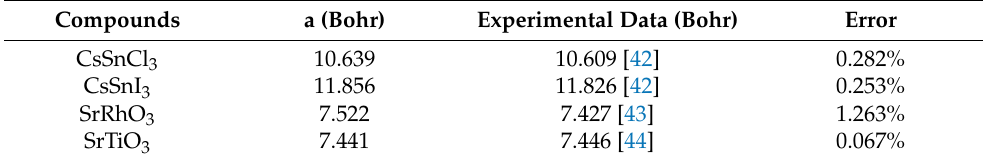
Table 1. Calculated lattice parameter (a) and previous calculations as well as experimental data.